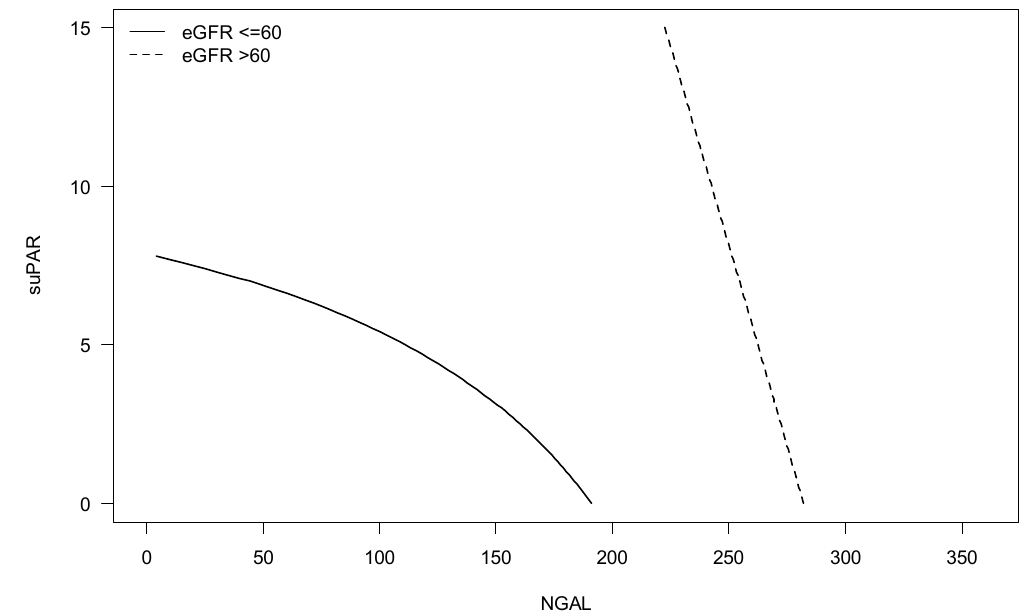
Figure A3. Three-biomarker cut-off approach with suPAR, NGAL and eGFR (3-variable interaction). The solid line represents cut-off values for the combinations of suPAR and NGAL when eGFR ≤ 60 and the dotted line represent cut-off values for the combinations of suPAR and NGAL when eGFR > 60.